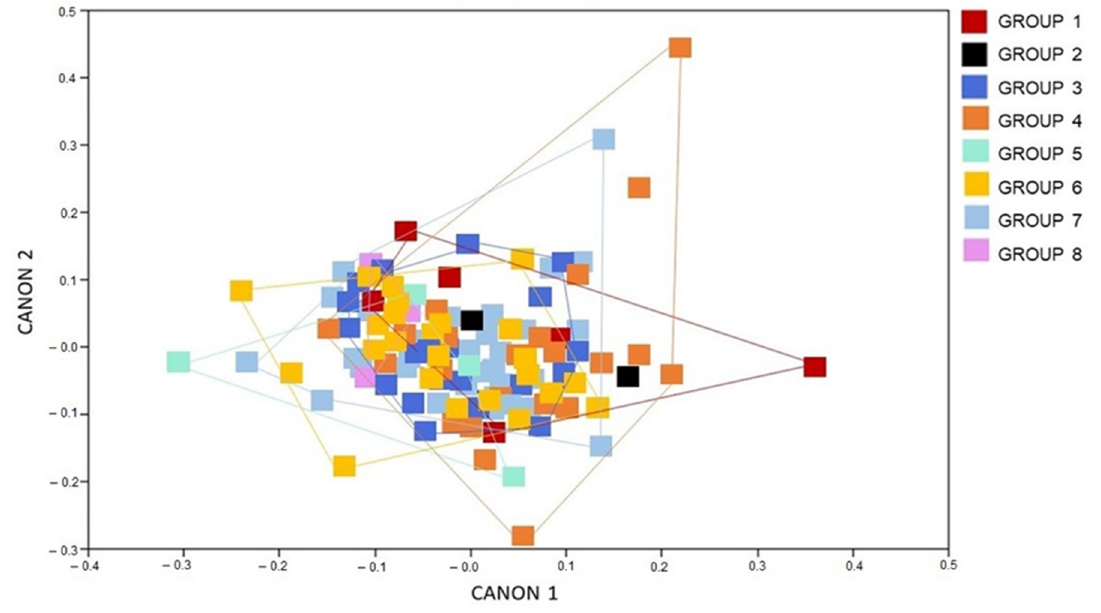
Figure 5. UPGMA Dendrogram of the Triatoma brasiliensis brasiliensis males, from various states and years (1912–2014), showing the phylogenetic distances between the groups.